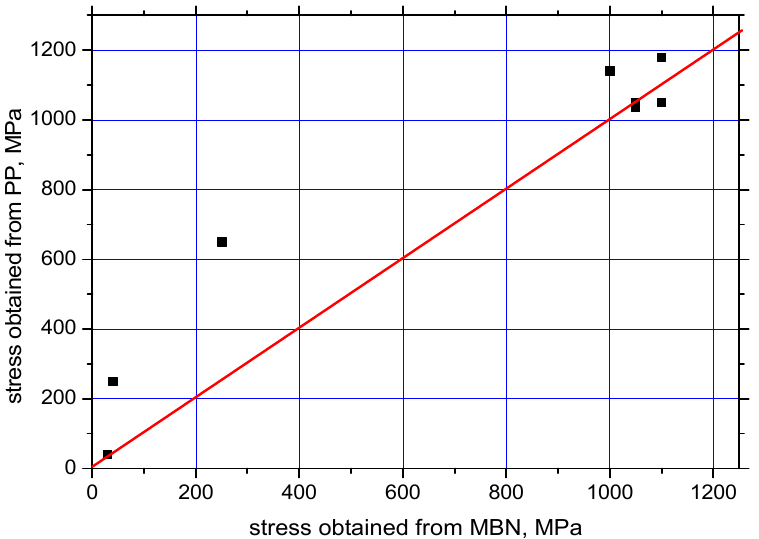
Figure 9. Prestress obtained from MBN versus PP .